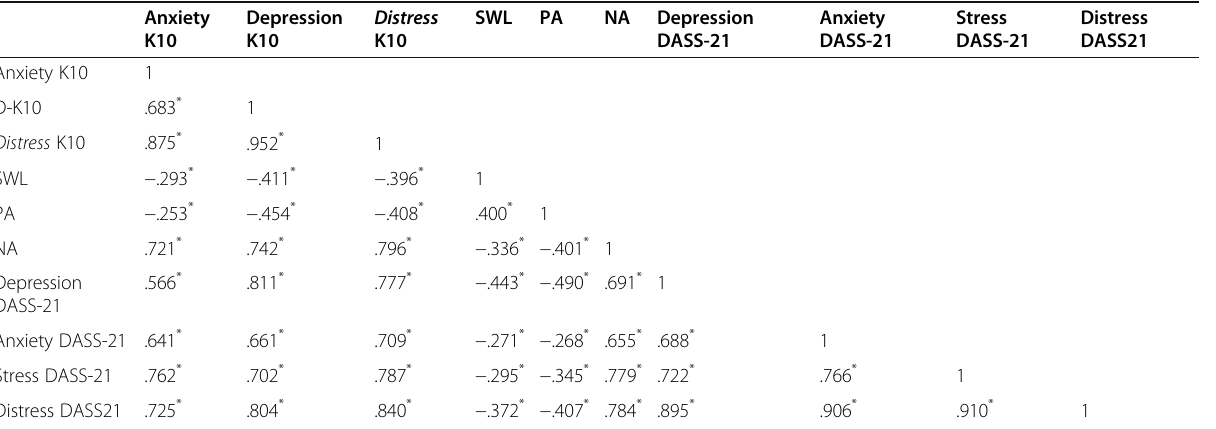
Table 5 Correlation between the variables used in the study Anxiety